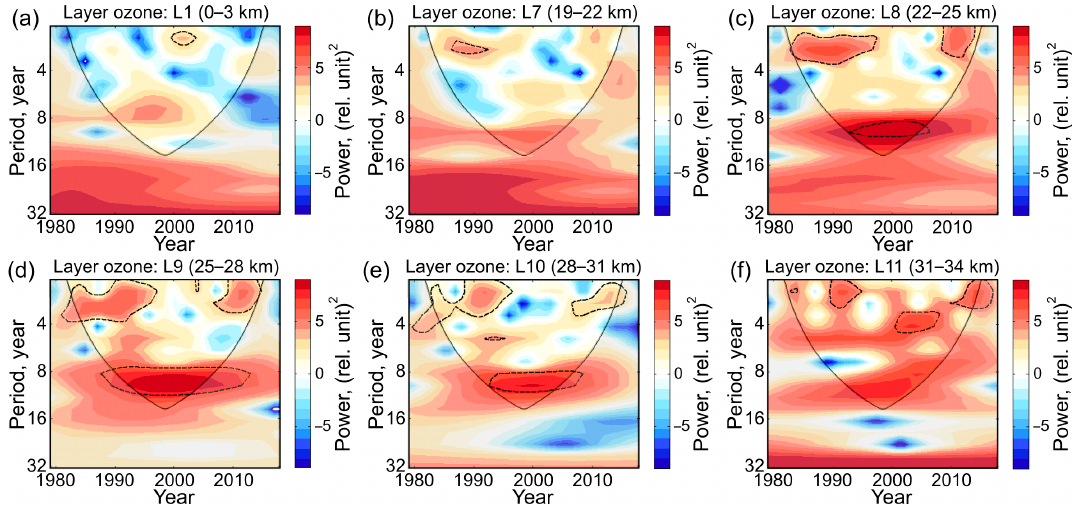
Figure 7. Periodicity in ozone variations over Faraday / Vernadsky from wavelet power spectra for the same layers L1 and L7–L11 as in Figure 6. From SBUV layer ozone data over Faraday / Vernadsky at ( a ) 0–3 km altitudes (L1) and ( b – f ) 19–34 km (L7–L11; see Figure 2). Contours show the 95% confidence level with lag-1 autocorrelation of 0.7.